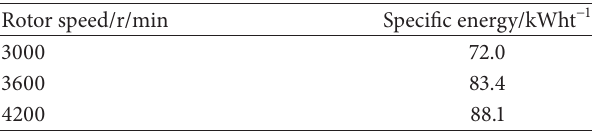
Table 3: Effect on rotor speed of advanced crusher on specific energy consumption.